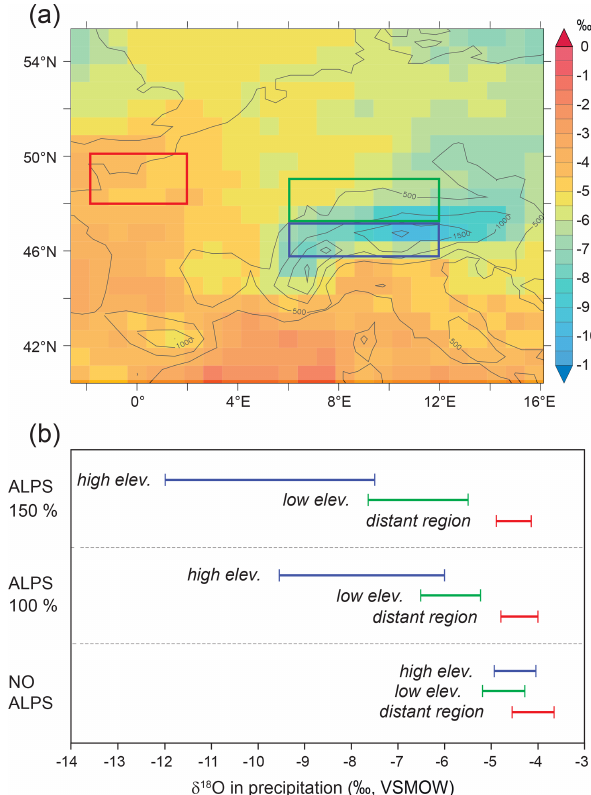
Figure 5. (a) Spatial distribution of ECHAM5-wiso simulated mean JJA δ 18 O w for the pre-industrial (Alps100) experiment for three regions: (1) within the blue rectangular area for elevations over 1600m (high elev.), (2) within the green rectangular area for ele- vations between 200 and 600m (low elev.), and (3) within the red rectangular area for distant regions (distant region). (b) Ranges of JJA δ 18 O w for the Alps150, Alps100, and NoAlps experiments for the selected regions (Botsyun et al.,